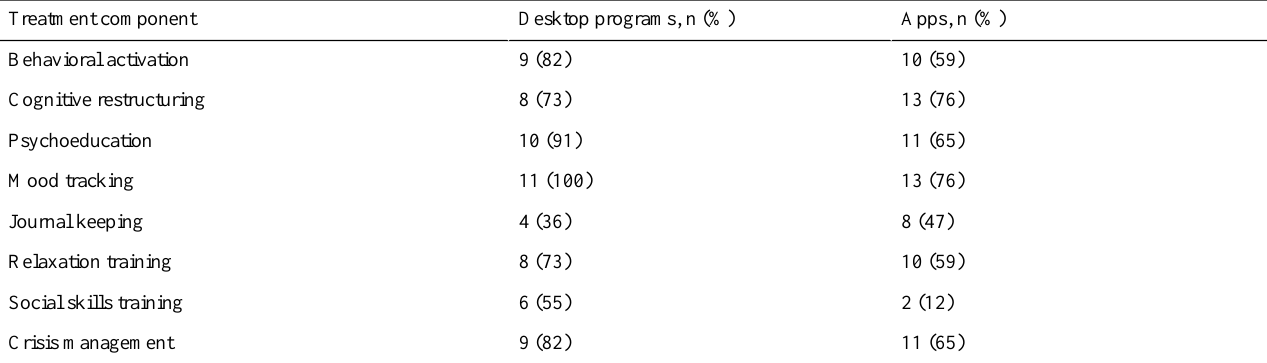
Table 2. Absolute numbers and respective availability of treatment components for desktop programs (N=11) and apps